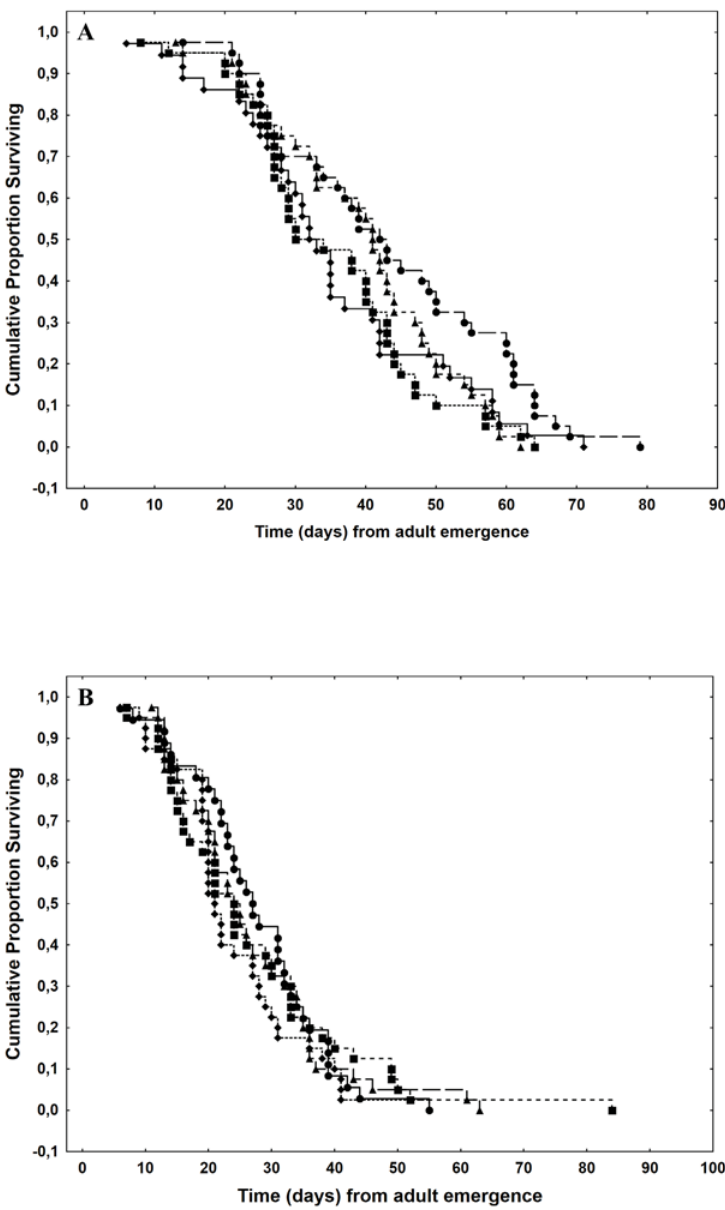
Fig 5. Survival curves for adult Diachasmimorpha longicaudata reared on Ceratitis capitata larvae that developed in different host fruit. Different fruit species are labelled with a different shape: Apple: circles; Fig: squares; Orange: triangles; Peach: diamonds. (a) males and (b) females.